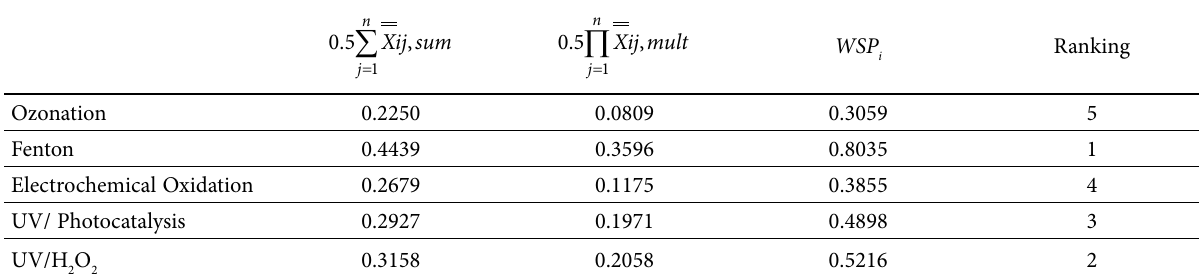
This table is calculated based on formula 3. Table 13. The results of